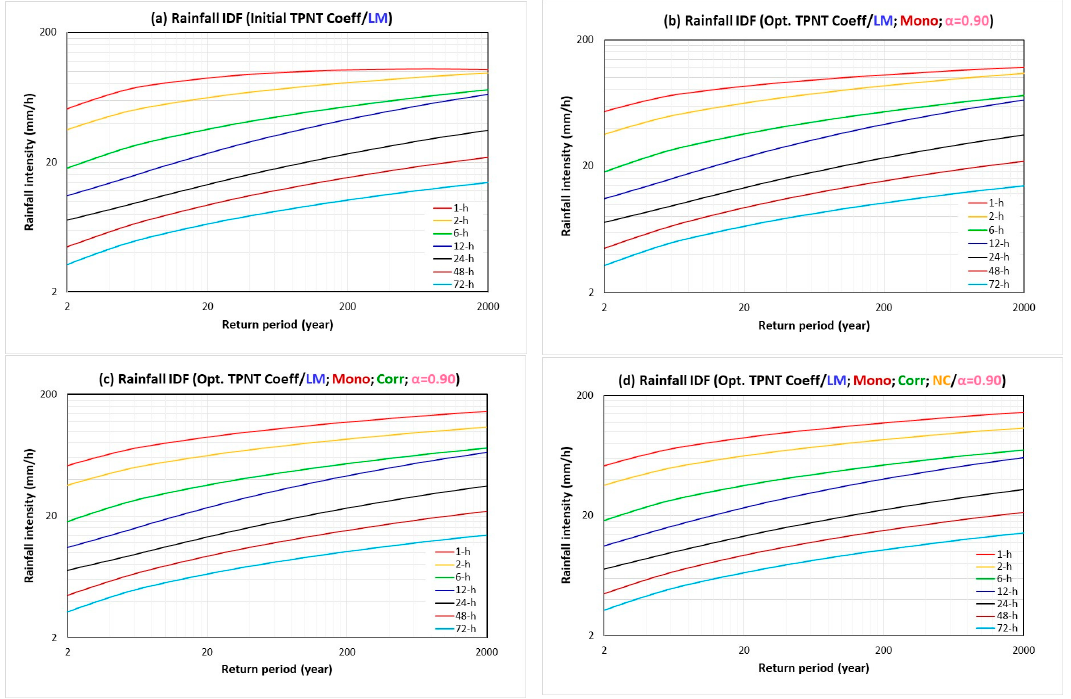
Figure 3. Multivariate TPNT modeling of rainfall intensity–frequency relationships of varying durations under different constraints which consider: ( a ) L-moments only; ( b ) L-moments and monotonicity; ( c ) L-moments, monotonicity and correlation; ( d ) L-moments, monotonicity, correlation and no crossover. Water 2019 , 11 , x FOR PEER REVIEW 15 of 20